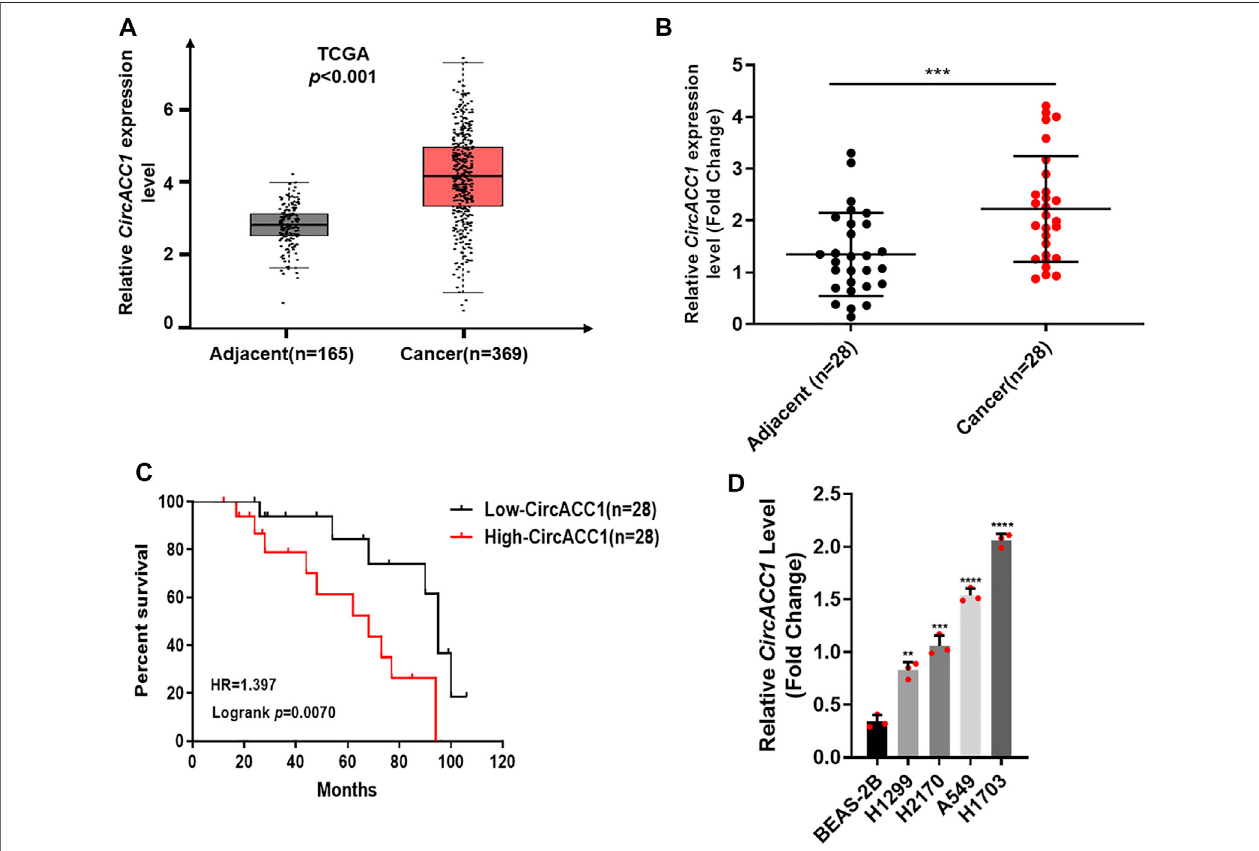
FIGURE 1 | Elevated level of circACC1 was found in NSCLC patients, and was negatively correlated with OS. (A) . The expression of circACC1 in NSCLC patients from TCGAdatabase; (B) . Theexpression ofcircACC1 in NSCLC tissuesand adjacent tissues byRT-qPCR. Dataare mean ± SD, n (cid:2) 28; (C) . Theassociationbetween circACC1 and OS by Kaplan-Meier curve; (D) . Determination of circACC1 expression in NSCLC cell lines and lung epithelial cell line BEAS-2B by RT-qPCR. Data are mean ± SD. ** p < 0.01, *** p < 0.001, **** p <